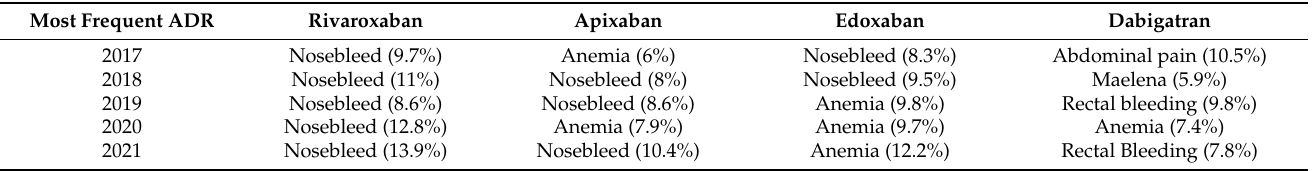
Figure 2. RIs for serious ADR, ICH ADR, and GI ADR for each molecule for all study years. In ( A ), RIs for serious ADR are shown. In ( B ), RIs for ICH ADR are shown. In ( C ), RIs for GI ADR are shown. The lower the RI, the safer the molecule. Rivaroxaban showed the lowest RI for serious ADR and ICH ADR while resulting as safe as apixaban for GI ADR. ADR: adverse drug reaction; GI: gastrointestinal; ICH: intracranial hemorrhage; RI: risk index. Table 3. Most frequent ADR and ADR rate for each DOAC from 2017 to